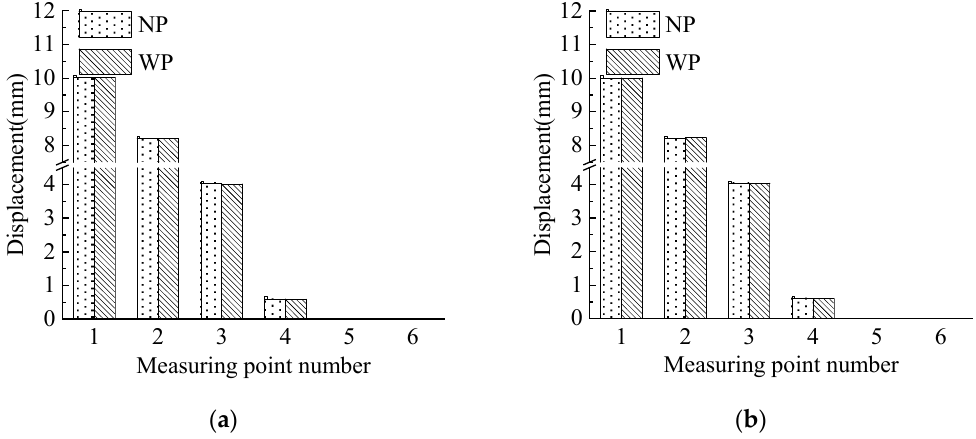
Figure 16. The vertical displacement of the rail seats and the bottom of the cast-in-place concrete during the running period. ( a ) Rail seats and ( b ) cast-in-place concrete.